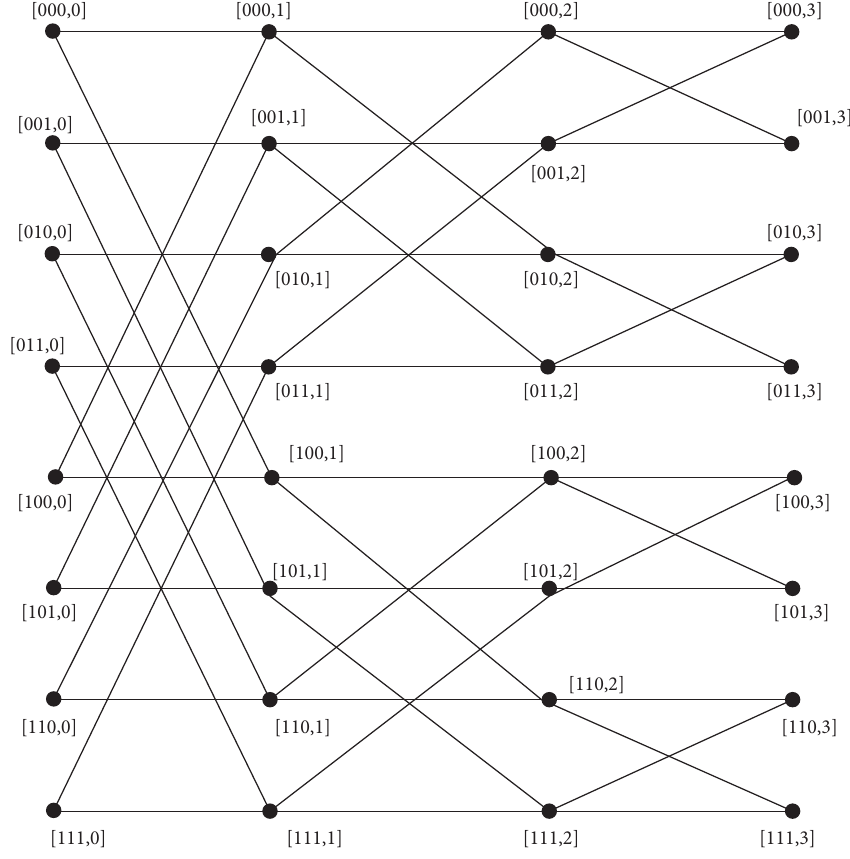
Figure 6: Normal representation of BF